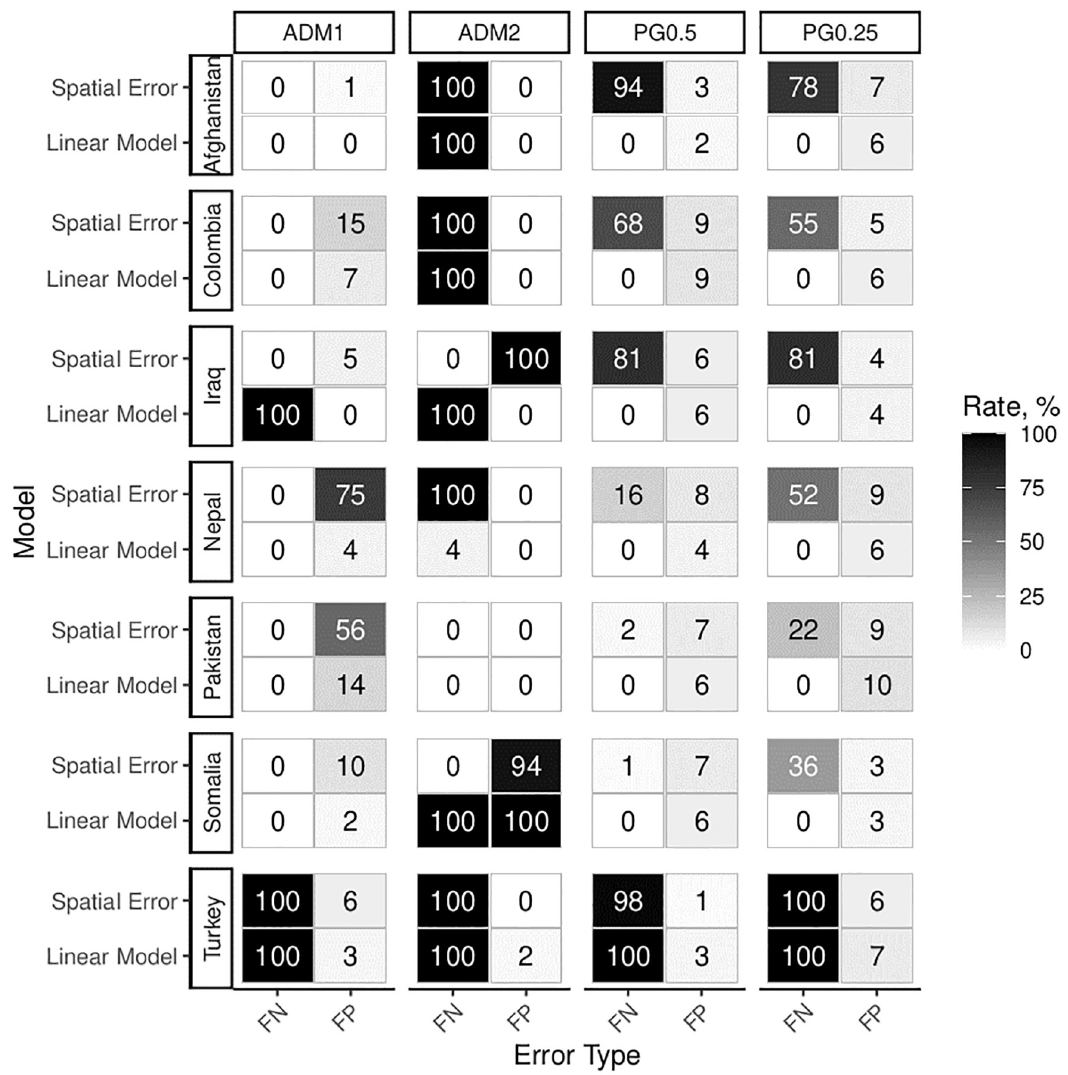
Fig 9. Experiments 3a and 3b (latent predictor, with and without causal effect) analyzed with spatial error and linear models. All models include area